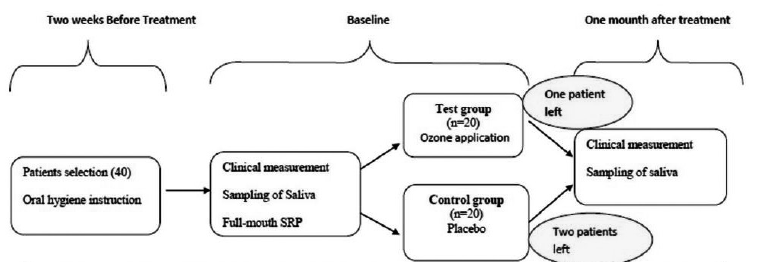
Figure 1- Research outline